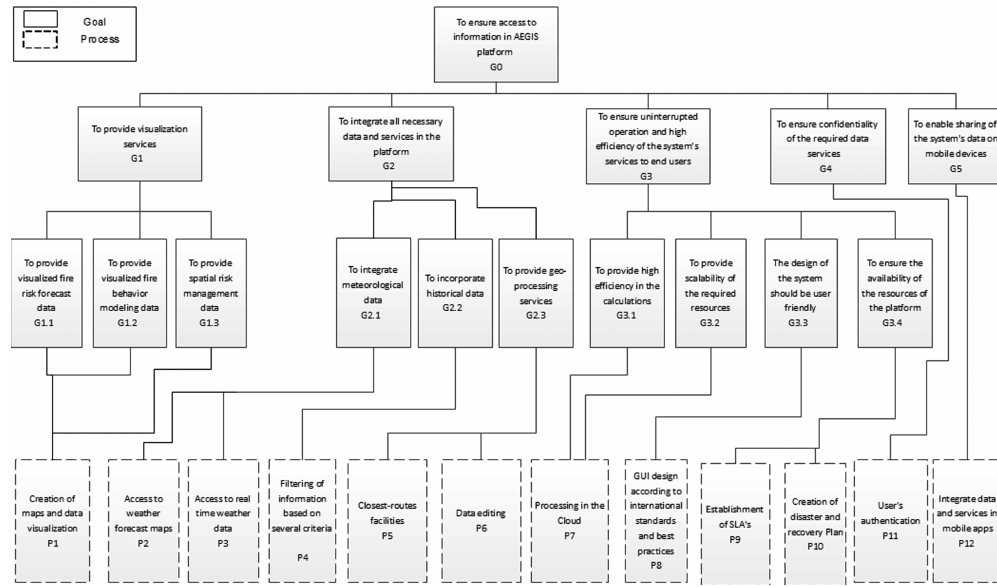
Figure 2. Goal–process diagram for development of the AEGIS